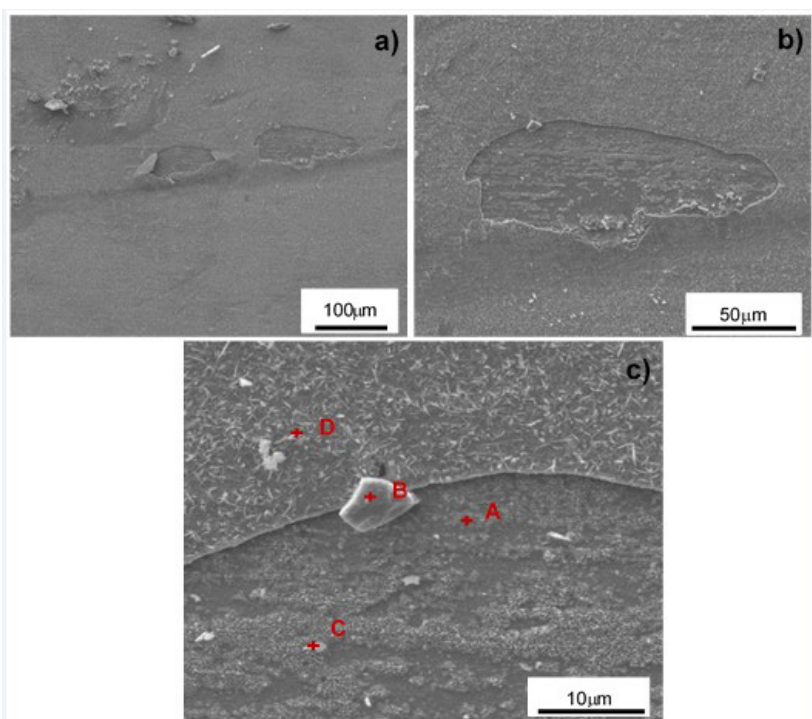
on maraging 350 alloy. 2